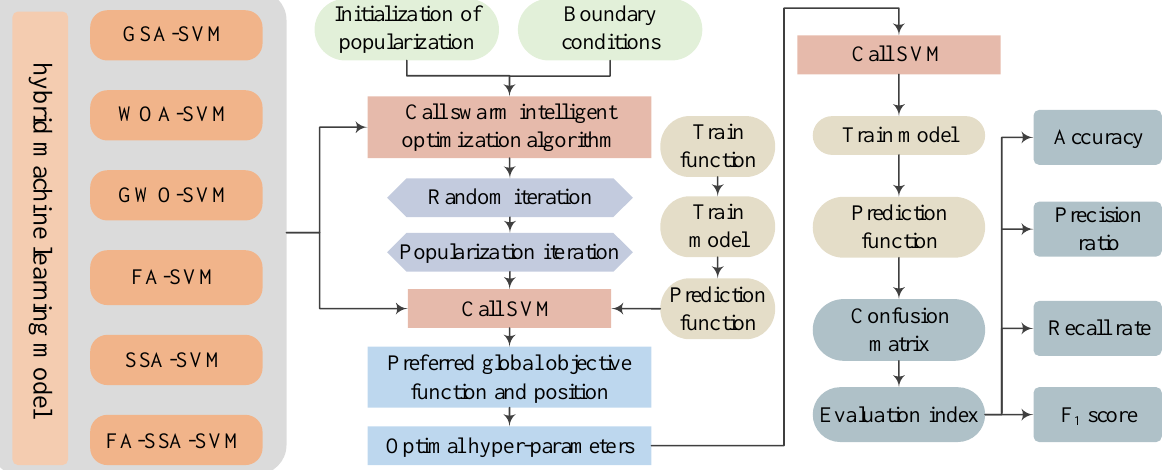
Figure 5. Principle of hybrid machine learning model.